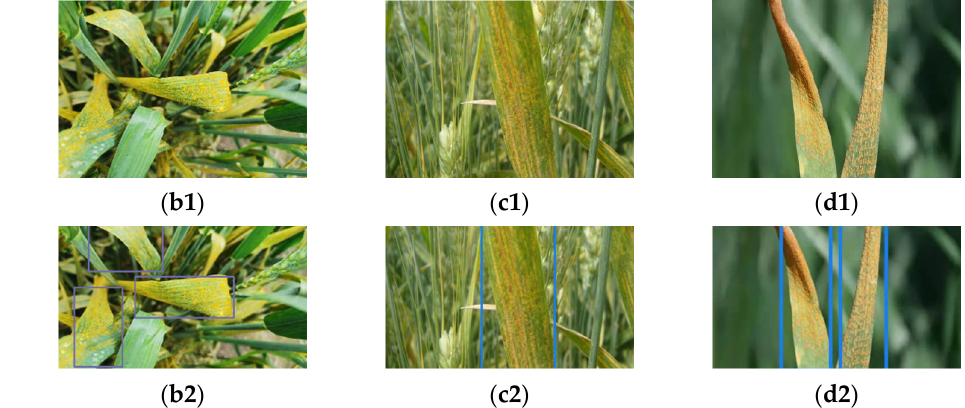
Figure 9. Wheat aphid. ( a1 ), ( b1 ), ( c1 ), and ( d1 ) are the original images; ( a2 ), ( b2 ), ( c2 ), and ( d2 ) are the recognition results.